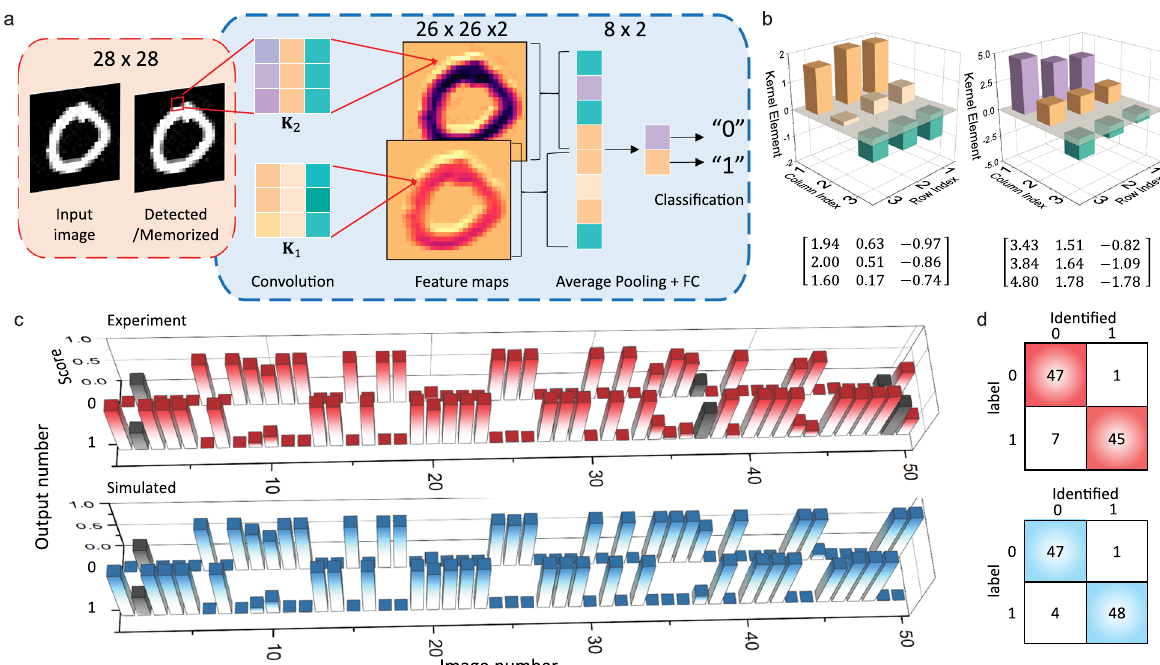
Fig. 4 bP-PPT array as an optoelectronic CNN for image recognition. a A CNN model for classifying handwriting numbers “ 0 ” and “ 1 ” from the MNIST dataset. The CNN consists of two convolution kernels, an average pooling layer, and a fully connected (FC) layer. The images captured by the bP-PPT array are further processed by the bP-PPT array in the electrical domain. b The 3 × 3 bP-PPT array is programmed with 5-bit precision to represent two kernels generated by of fl ine training. c The experimental results (top, red) for image recognition using the bP-PPT array are compared with the simulation results (bottom, blue). Each bar is the score indicating the possibility of the CNN recognizing an image in the MNIST image library. The incorrectly recognized cases are in gray color. d The experimental and simulated confusion table for 100 images from the MNIST dataset. Colored diagonal elements in the table indicate the correctly identi fi ed